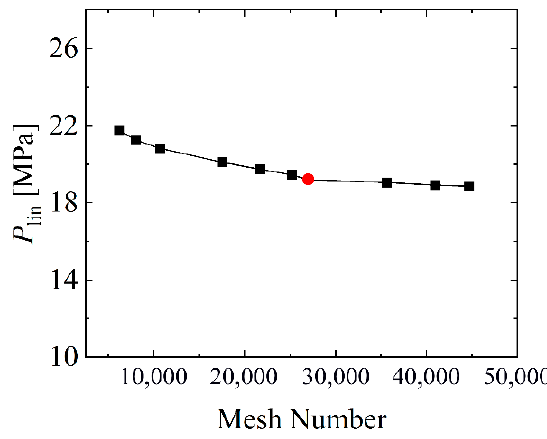
Figure 7. Convergence study of ST-1 sphere-segmented toroidal shell.